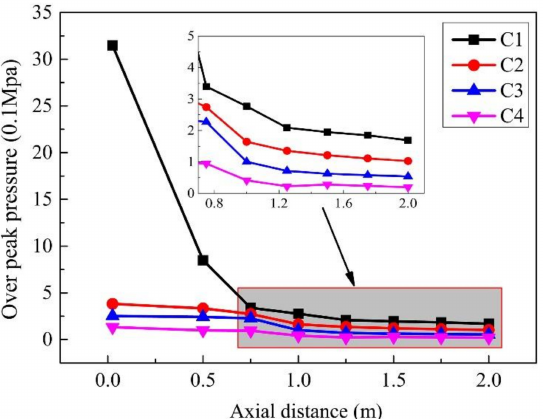
Figure 21. The peak pressure of the gauge points in different horizontal positions of